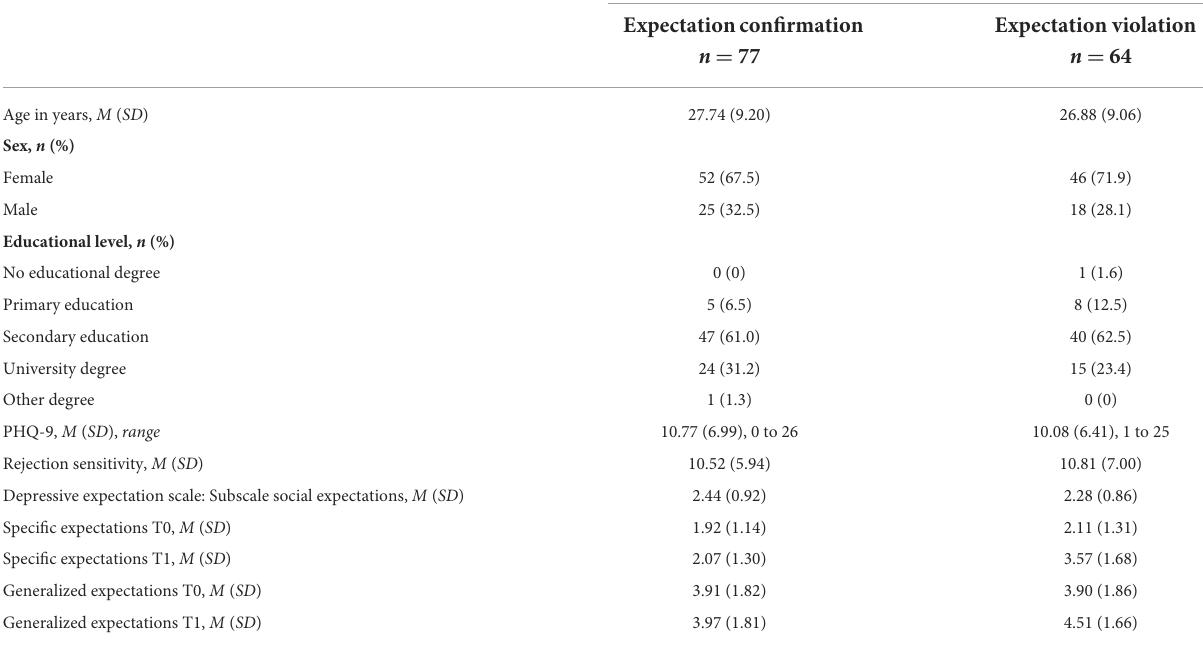
TABLE 1 Sociodemographic characteristics, baseline characteristics and self-rating of the self-rating on social expectations of the sample ( N = 141).